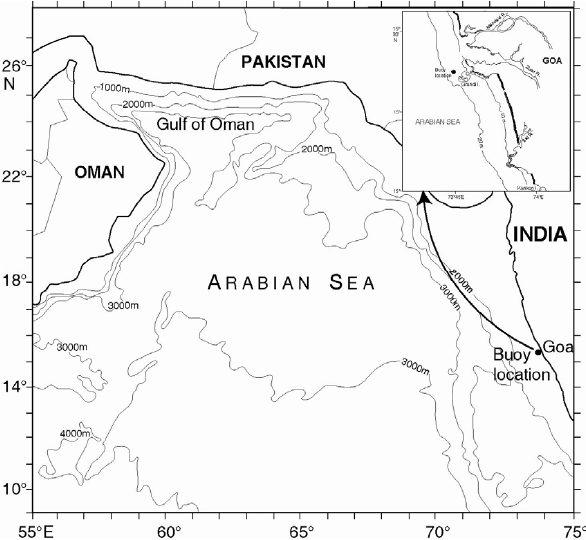
Figure 1. Wave measurement location in the north Indian Ocean. The water depth at the Fig. 1. Wave measurement location in the north Indian Ocean. The measurement location is 14 m. water depth at the measurement location is 14m.